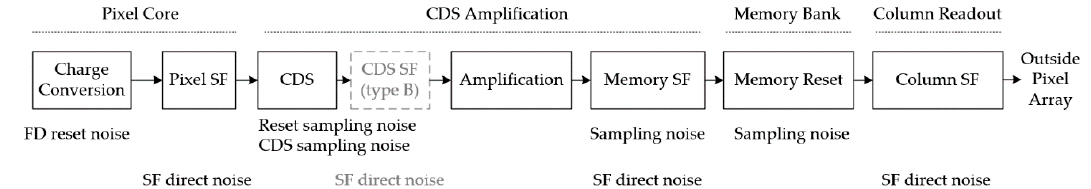
Figure 7. Noise diagram overview based on pixel operations. In the Type B pixel, there is an additional source follower (SF) direct noise due to the CDS SF.